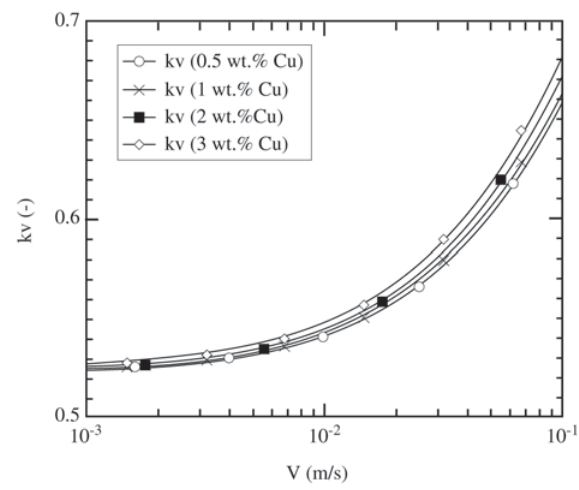
Figure 5. Solute trapping effects in Al-Cu alloys in the selected range of growth